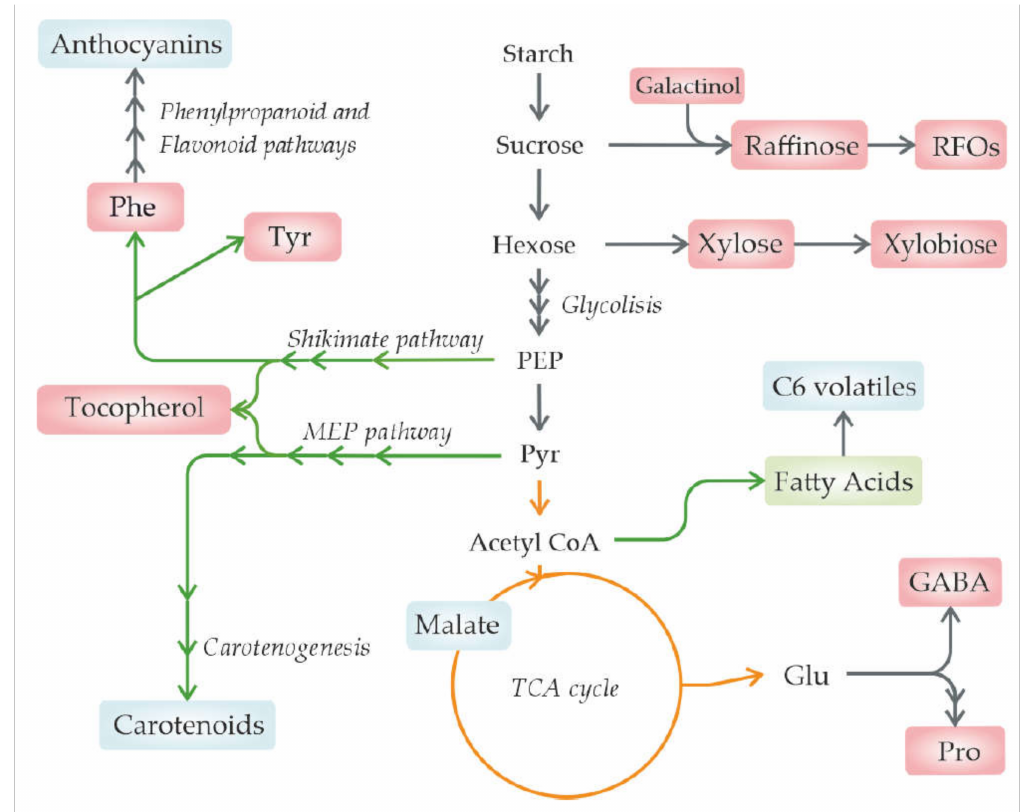
Figure 1. General effects of heat stress in fruit metabolism. Red: increase; blue: decrease; and green: changes in its patterns. Arrows: grey: cytosol; orange: mitochondria; and green: plastids. RFOs: raffinose family of